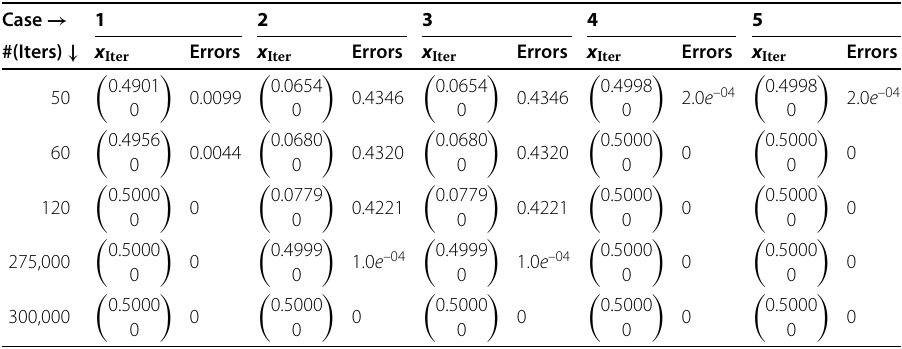
Table 2 Influence of the step size parameters λ n and γ n for the initial vector (0,0) with the 4